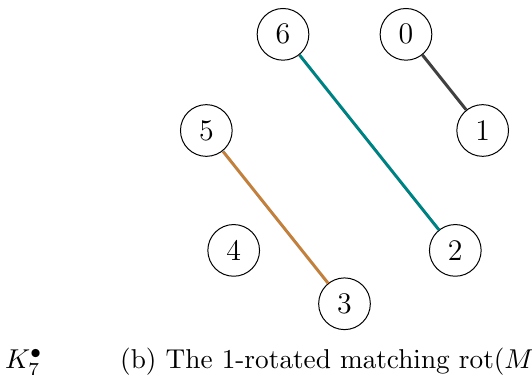
Figure 3: Example 1-rotated RPM